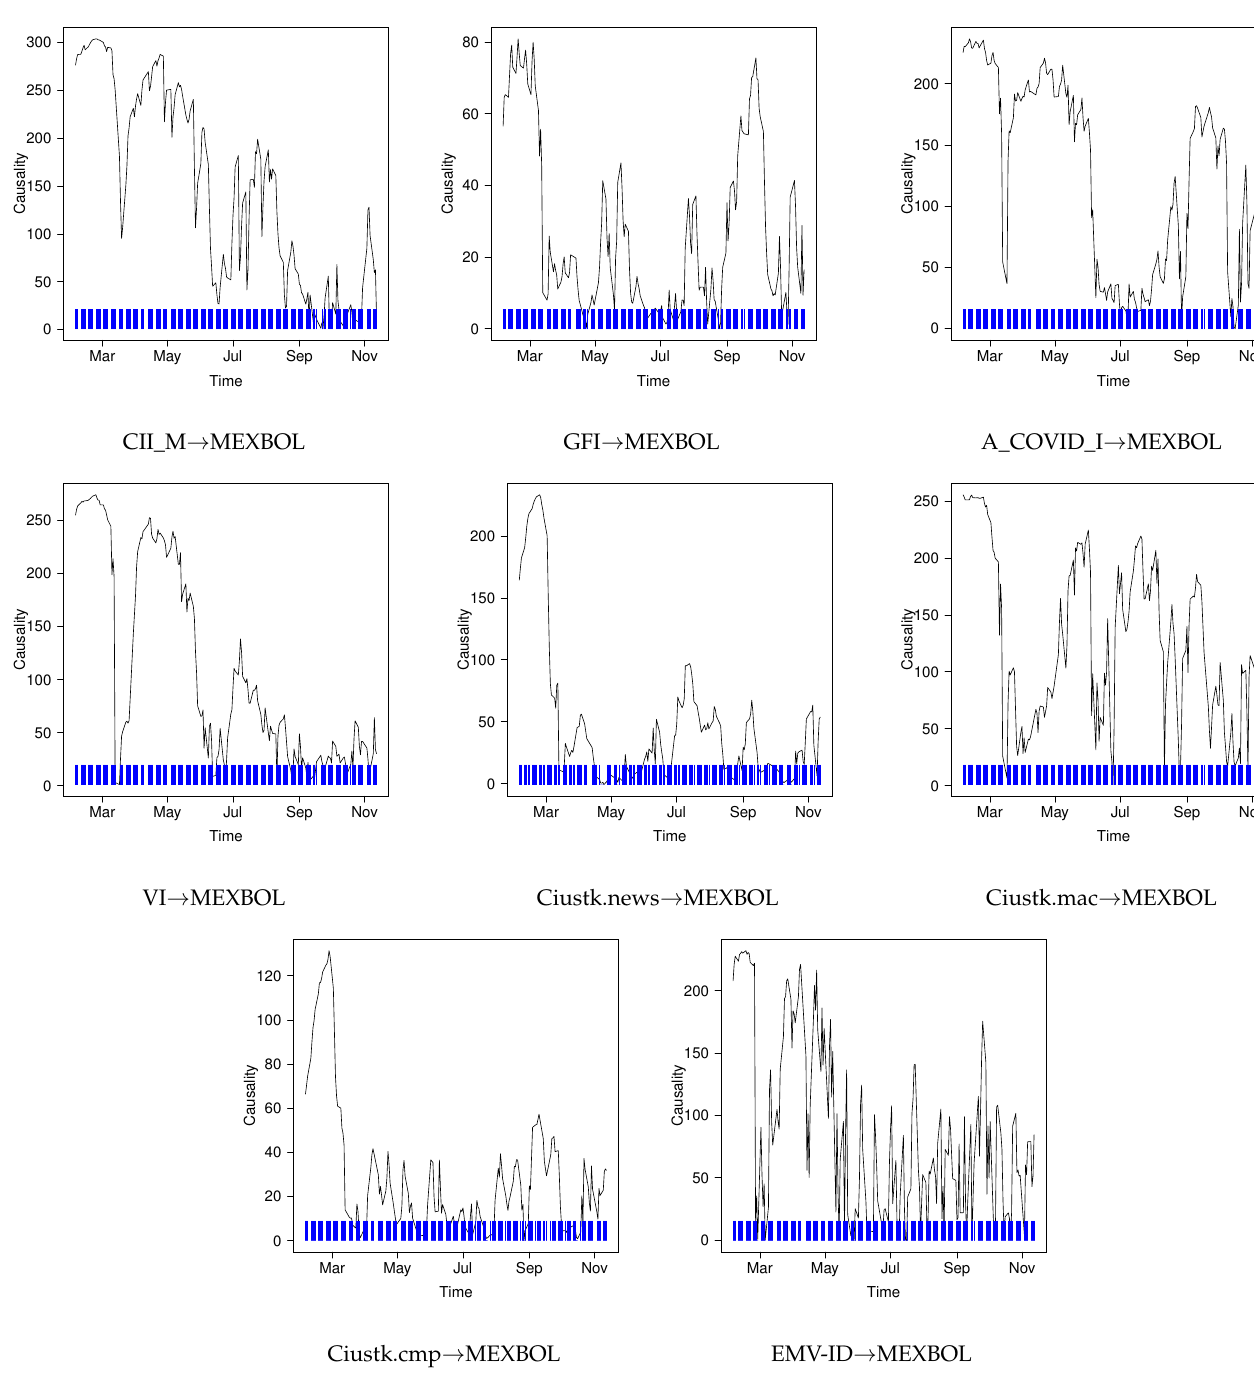
Figure 1. Instantaneous, one-way Granger-causality from news series to MEXBOL (DCC- GARCH